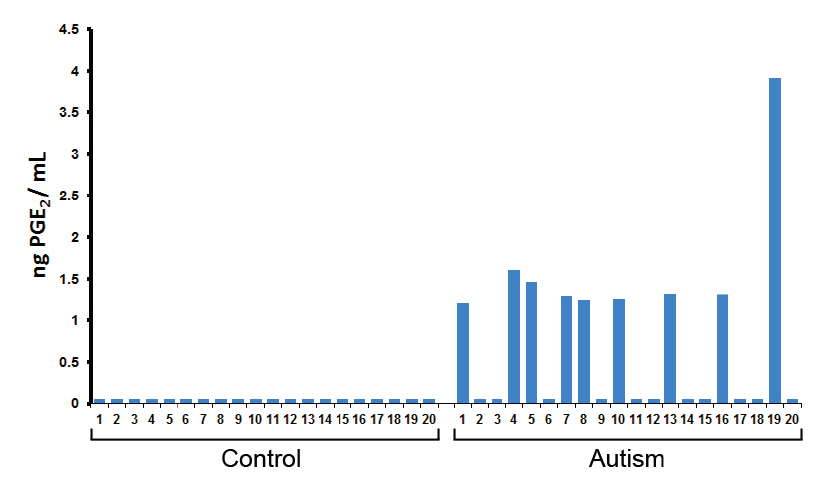
Figure 3. Plasma PGE 2 levels of control subjects and autism patients. Plasma PGE 2 levels were quantified by LC/MS for control subjects ( n = 20) and autism patients ( n = 20). All control samples were under the detection limit of <0.71 ng/mL. In contrast, PGE 2 levels were detected in 9 of the 20 plasma samples from ASD individuals, ranging from 1.21 to 3.91